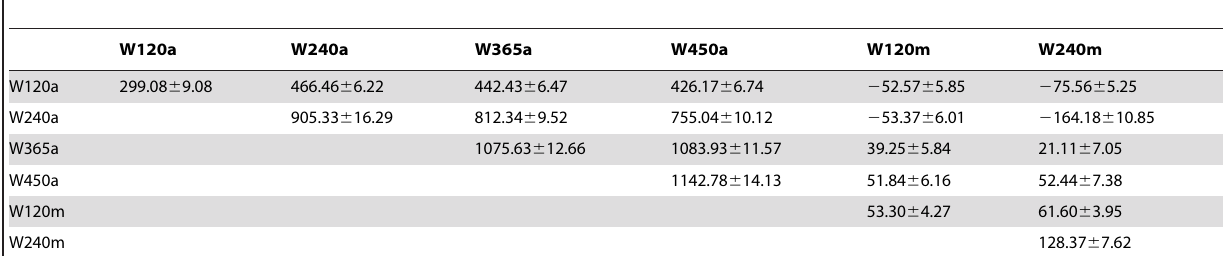
Table 2. Estimates of the mean and standard-deviation of direct (a) and maternal (m) effects of variance (on diagonal) and covariance (above diagonal) for weight at 120, 240, 365 and 450 days old.